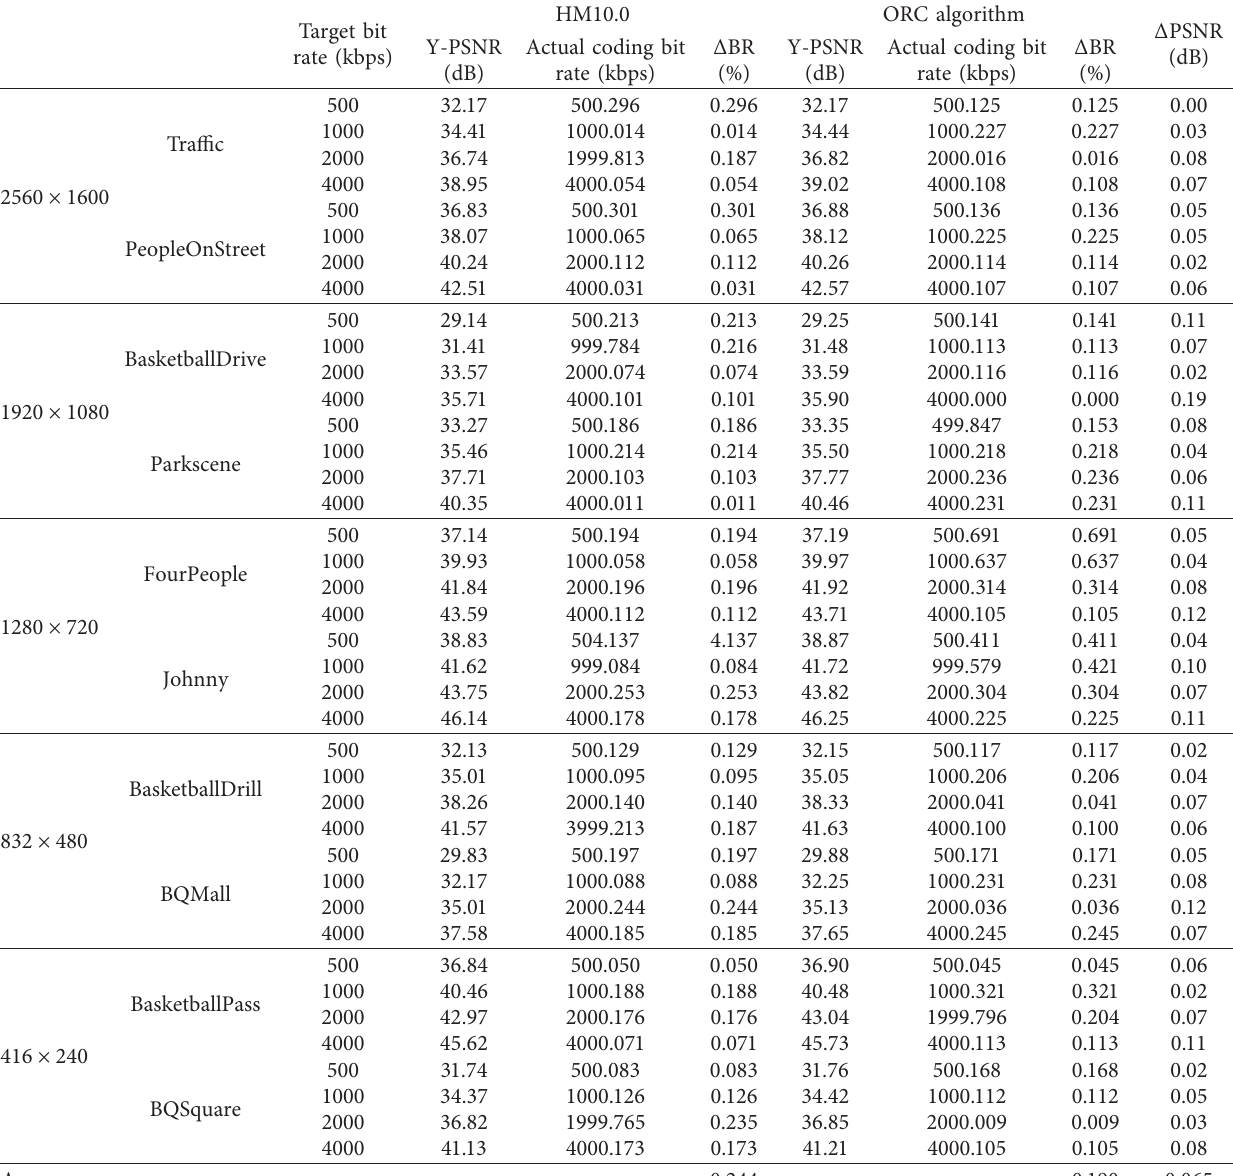
Table 2: Experimental comparison data between the ORC algorithm and the K0103 algorithm.